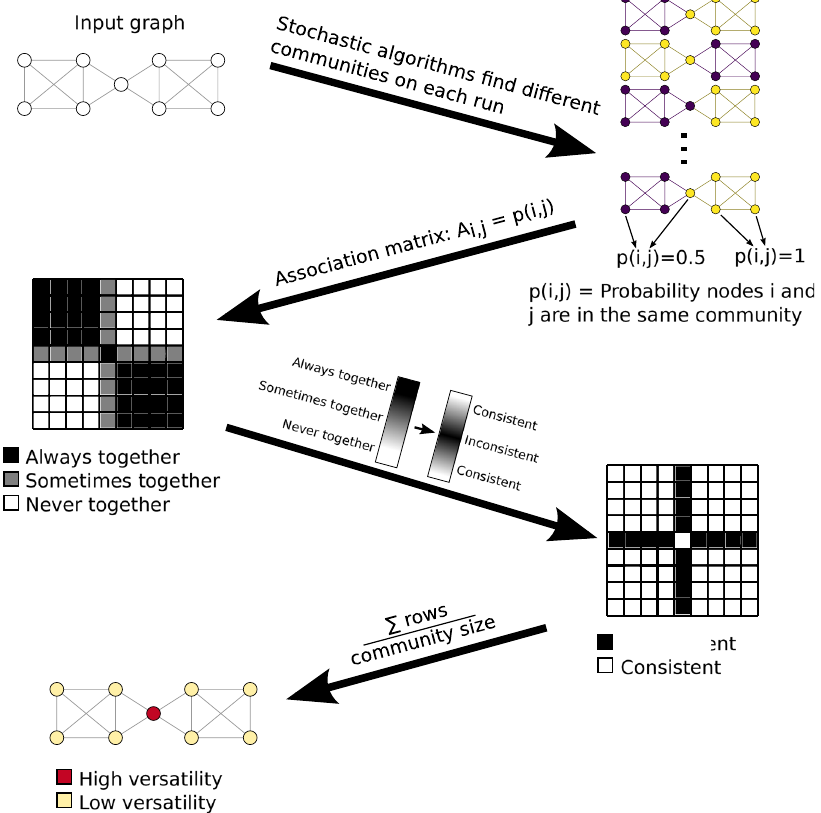
Figure 1. A schematic overview of versatility. A stochastic community detection algorithm is run many times, generating a collection of graph partitions. Each pair of nodes corresponds to a cell in the association matrix, which describes the sample probability that any two nodes will be grouped in the same community. A transformation function is applied to this matrix, so that pairs of nodes that are consistently grouped either in the same community or in a different community are given low values, and pairs which are only sometimes in the same community are given high values. The sum is taken for each node’s possible pairs, and normalised by the mean size of the communities weighted by the node’s community membership. The resulting normalised sum is the node’s versatility.